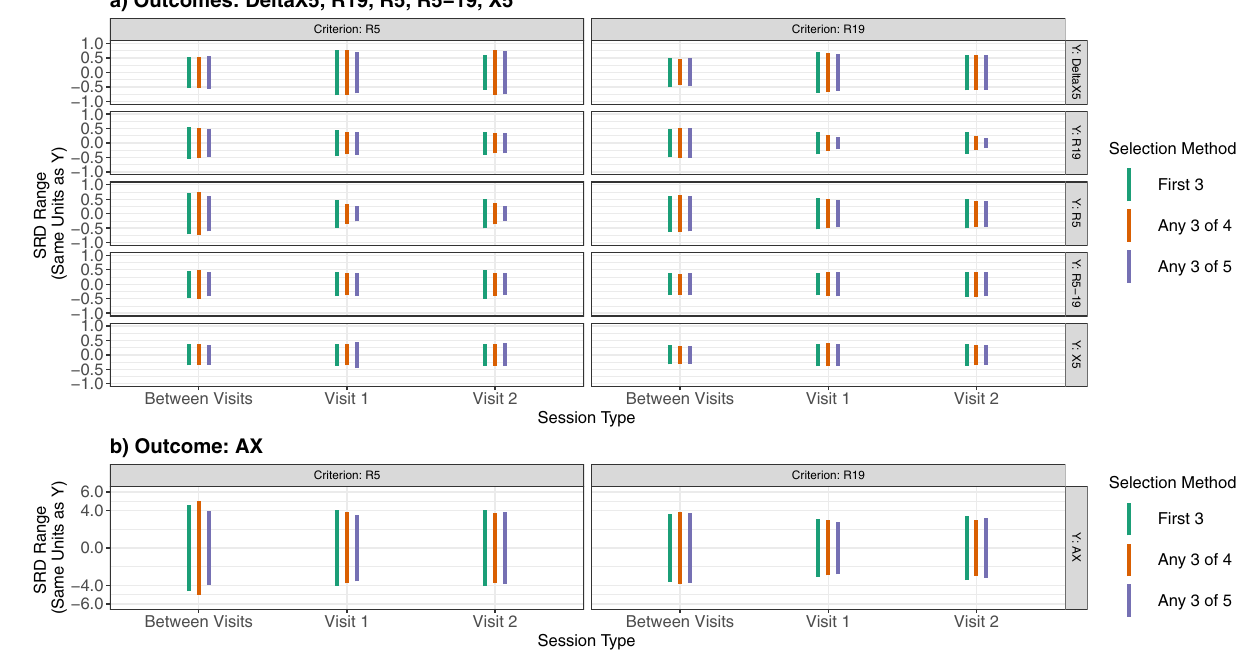
Figure 2. Minimum smallest real difference (SRD) range within and between sessions for each trial selection method stratified into two vertical sets of panels by coefficient of variation thresholding criteria and six horizontal sets of panels by outcome used as model fit response (Y’s). The horizontal sets of panels stratified by outcome were split into sections “a” and “b” to account for the different y-axis scale associated with reactance area, AX. SRD units are the same as the outcomes, so the y-axis scales vary by outcome metric as follows. In panel “a”: outcomes (low- (5 Hz) and mid-frequency (19 Hz) resistance (R5, R19) and reactance (X5), frequency dependence of resistance (R5-19), delta X5 (∆ = X5 inspiratory—X5 expiratory; 14 ), cm H 2 O ·s/L). In panel “b”: reactance area (AX, cm H 2 O/L). SRD was calculated as either the within or between session standard deviation (i.e., root mean square error (RMSE) from model fits) multiplied by √2 × 1.96 (SRD = RMSE × 2.77) 25 . What is termed here as the minimum SRD range was calculated as zero (i.e., assuming no difference between measurements using the same approach) ± SRD. Therefore, smaller minimum SRD ranges represent less measurement variability and greater sensitivity to detect a true difference 24,25